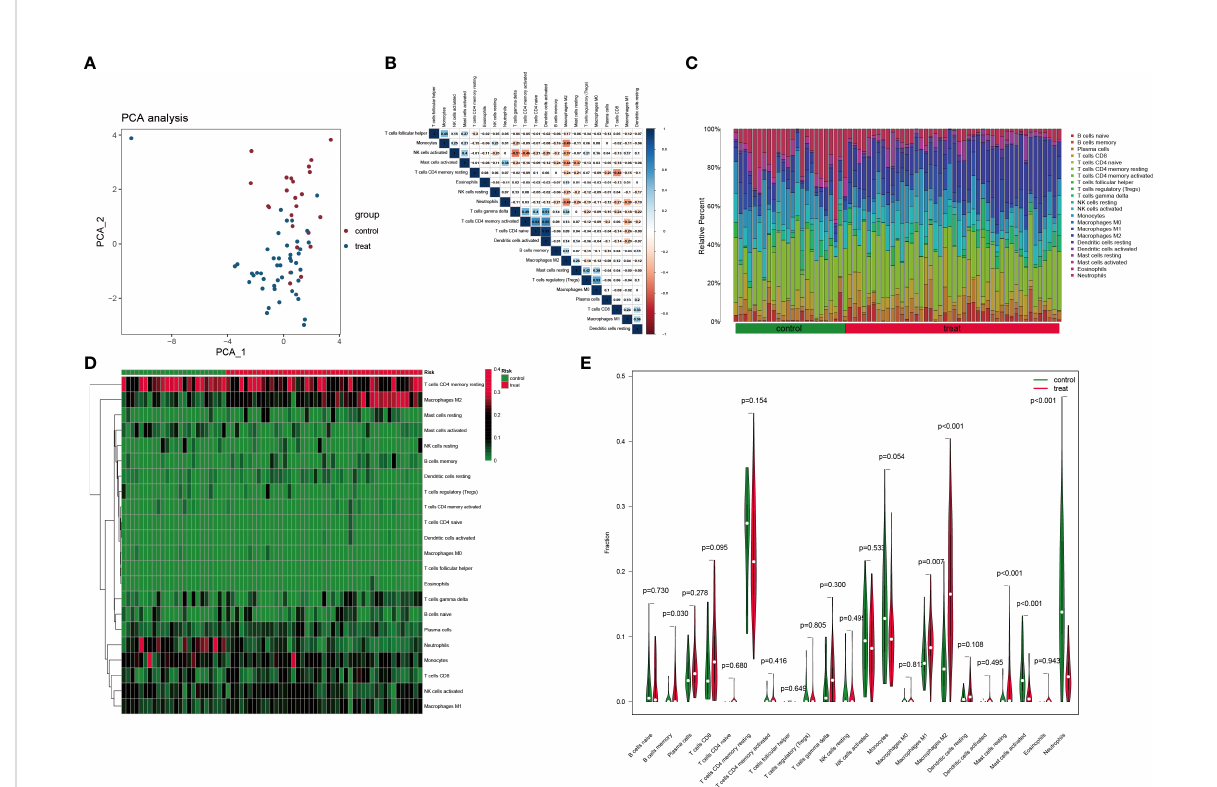
FIGURE 8 Immune cell in fi ltration analysis based on the CIBERSORT algorithm. (A) PCA performed on two groups. Red points indicate normal samples and green points indicate DN samples. (B) Correlation matrix of in fi ltration degree of immune cells in DN samples. (C) The abundance of different immune cells in each sample. (D) The in fi ltration degree of 22 immune cells in each sample. Red squares indicate higher immune in fi ltration expression and green squares indicate lower expression. (E) Violin plots of the differential analysis of different immune cells between two